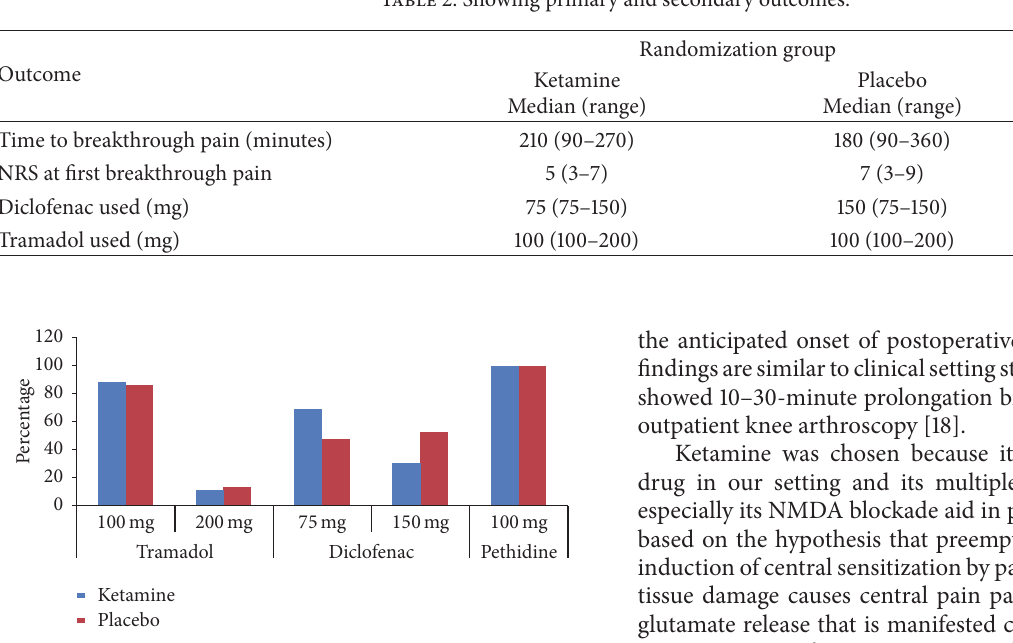
Figure 3: Graph showing postoperative analgesic drugs.